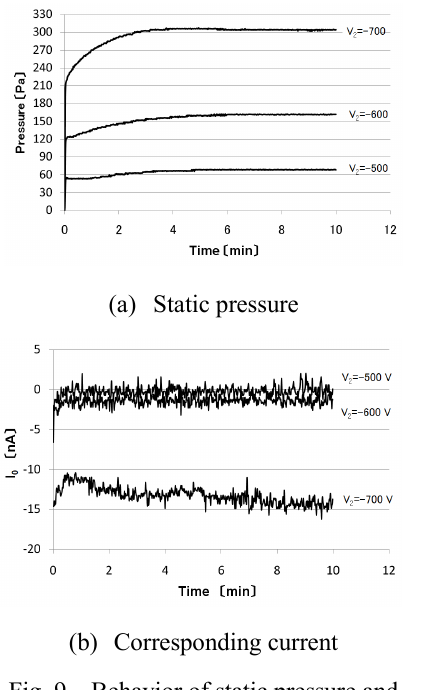
Fig. 9 Behavior of static pressure and Fig. 10 Mean static pressure and mean